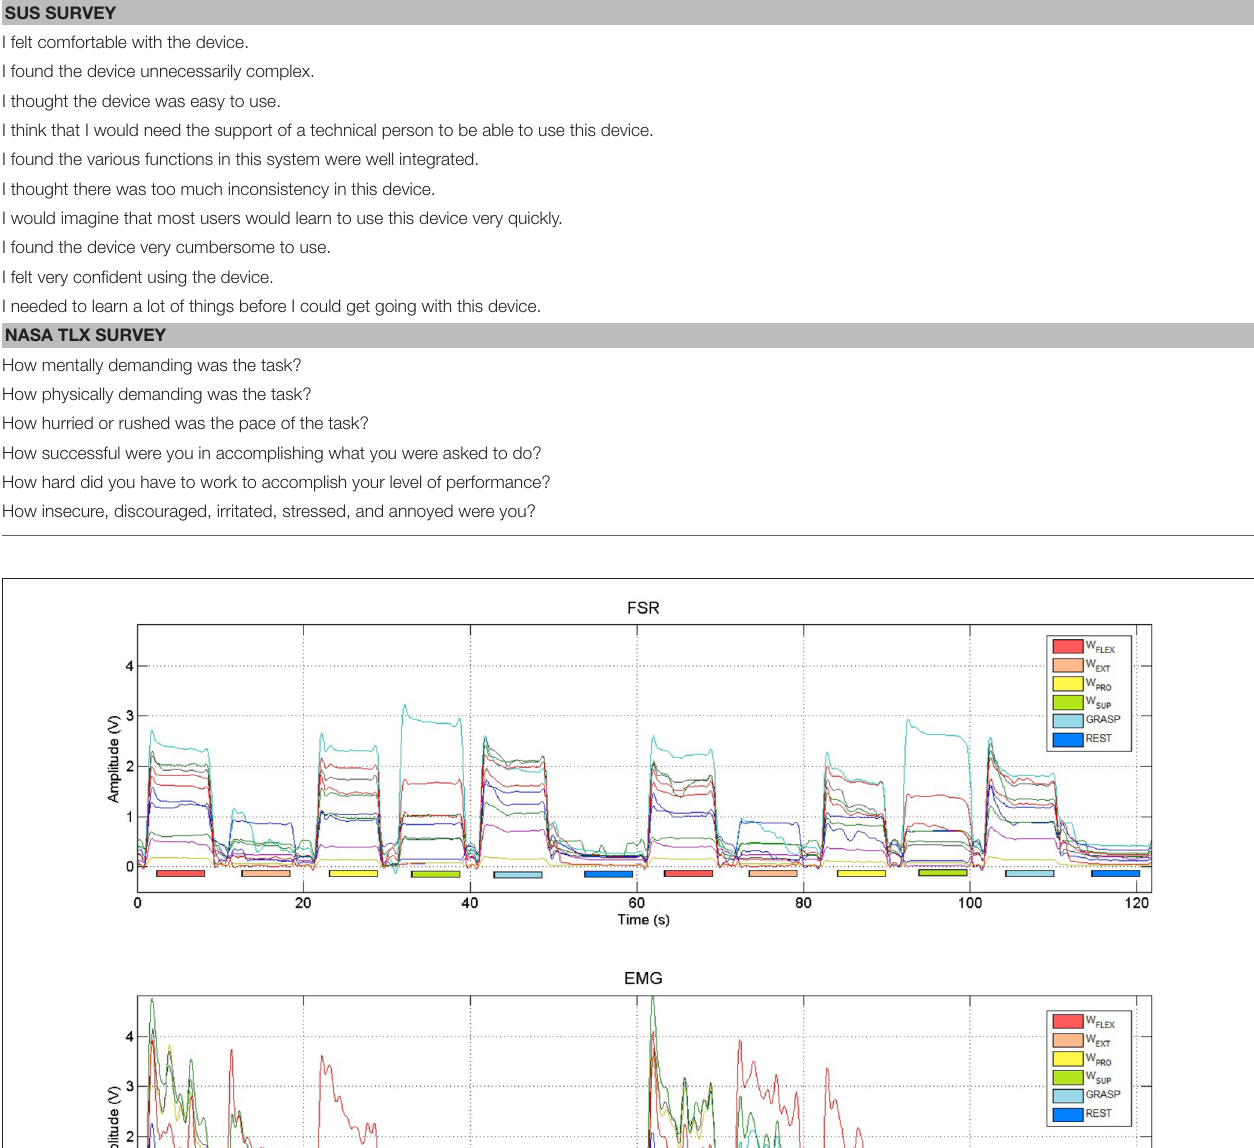
TABLE 2 | The statements found in the SUS and NASA TLX surveys. SUS SURVEY